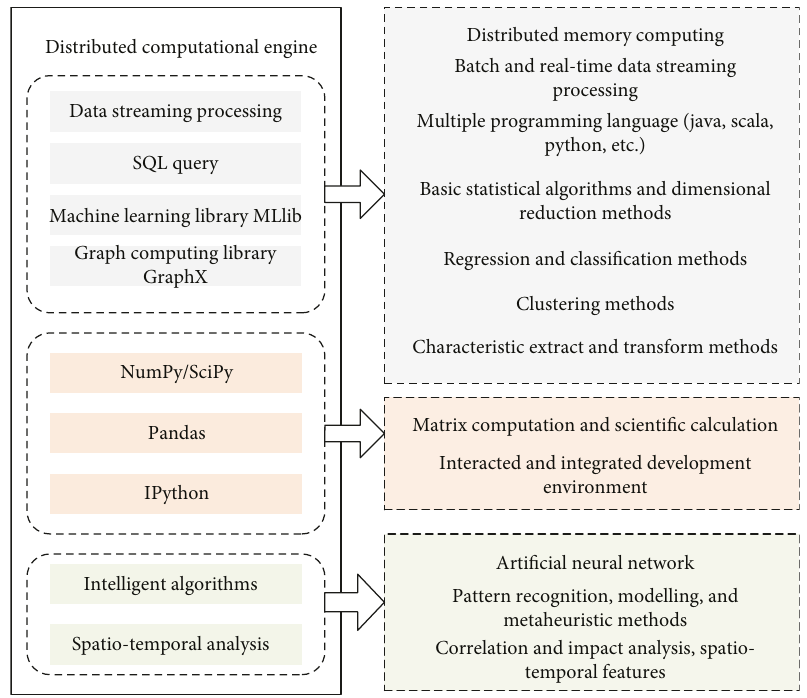
Figure 6: Structure of Big Data platform computational